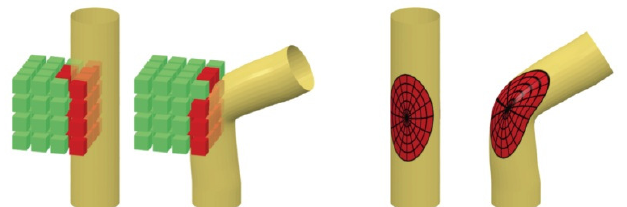
Figure 14. Illustrations of the differences between extrinsic CNN and intrinsic CNN. Intrinsic methods (right) work on the manifold rather than its Euclidean realization. The figure is originally from [120]. Reproduced with permission from Michael Bronstein, NIPS Proceedings; published by Neural Information Processing Systems Foundation, Inc.,